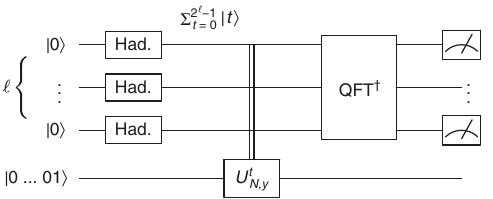
Fig. 4 A circuit proving H 2 FF exp ) H 2 SEEM exp . In this ‘ -qubit phase estimation circuit, the gate ~ U t is the α -approximation of e − iHt ; it is implemented ef fi ciently for polynomial ‘ (or exponential t ) if H ∈ FF exp . In that case, the circuit represents a SEEM. The FF error α accumulates additively, reducing con fi dence ( η ) and adding demolition to the